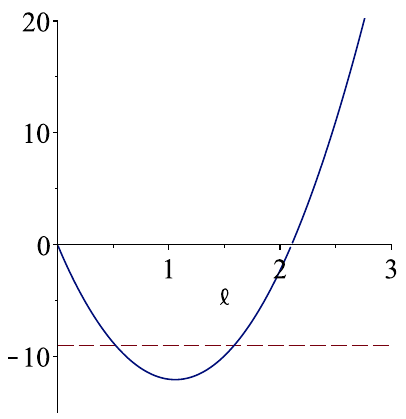
Figure 4 . Violation of the BF bound in heterotic (cid:13)ux vacua. The dangerous eigenvalue is displayed in units of 1 and the BF bound is -9 in this R 2 AdS